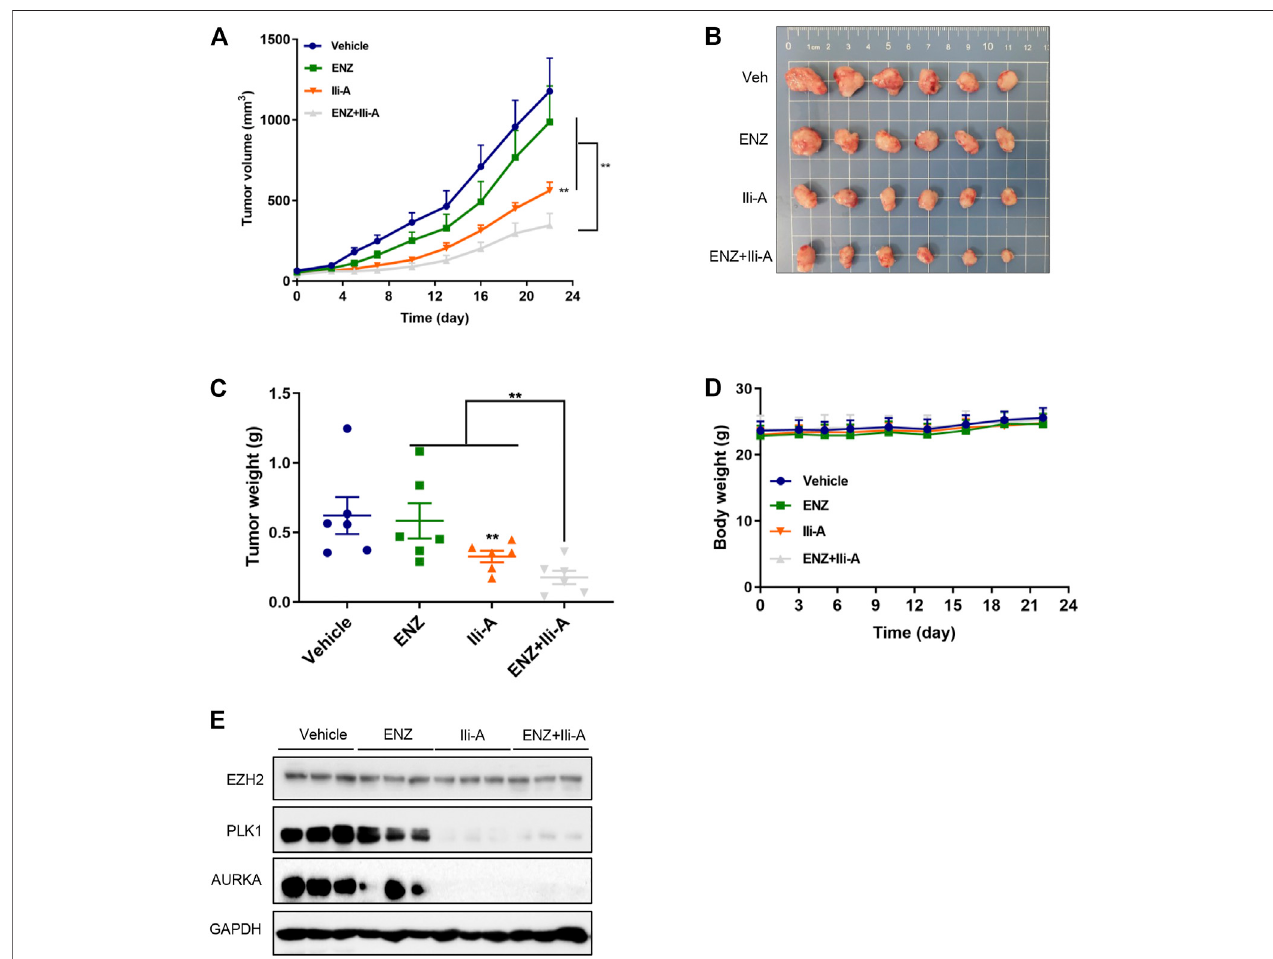
FIGURE 6 | Ili-A enhances the anti-tumor effects of enzalutamide in vivo . Mice bearing 22Rv1 xenografts ( n (cid:2) 8 mice per group) received vehicle, Ili-A (10 mg/kg, i. p.), ENZ (10 mg/kg, i. p.) or a combination of Ili-A and ENZ, as indicated, six times per week. (A) Tumor volume in different groups (tumor volume was measured twice every week). (B) Images of xenograft tumors harvested at day-22. (C) Weight of xenograft tumors in different groups. (D) Body weight of Mice in different groups. (E) Western blotting was done to detect EZH2 and target proteins in tumors undergoing monotherapy or combination with Ili-A and